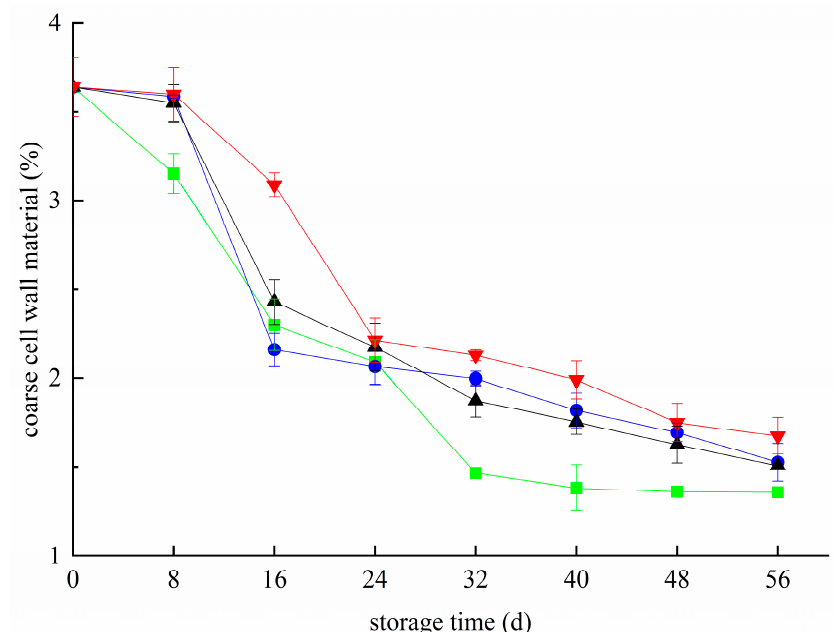
Figure 1. Effect of coarse cell wall material in blueberry under different treatments. ■ : control; ● : T; ▲ : Z: ▼ : T plus Z.